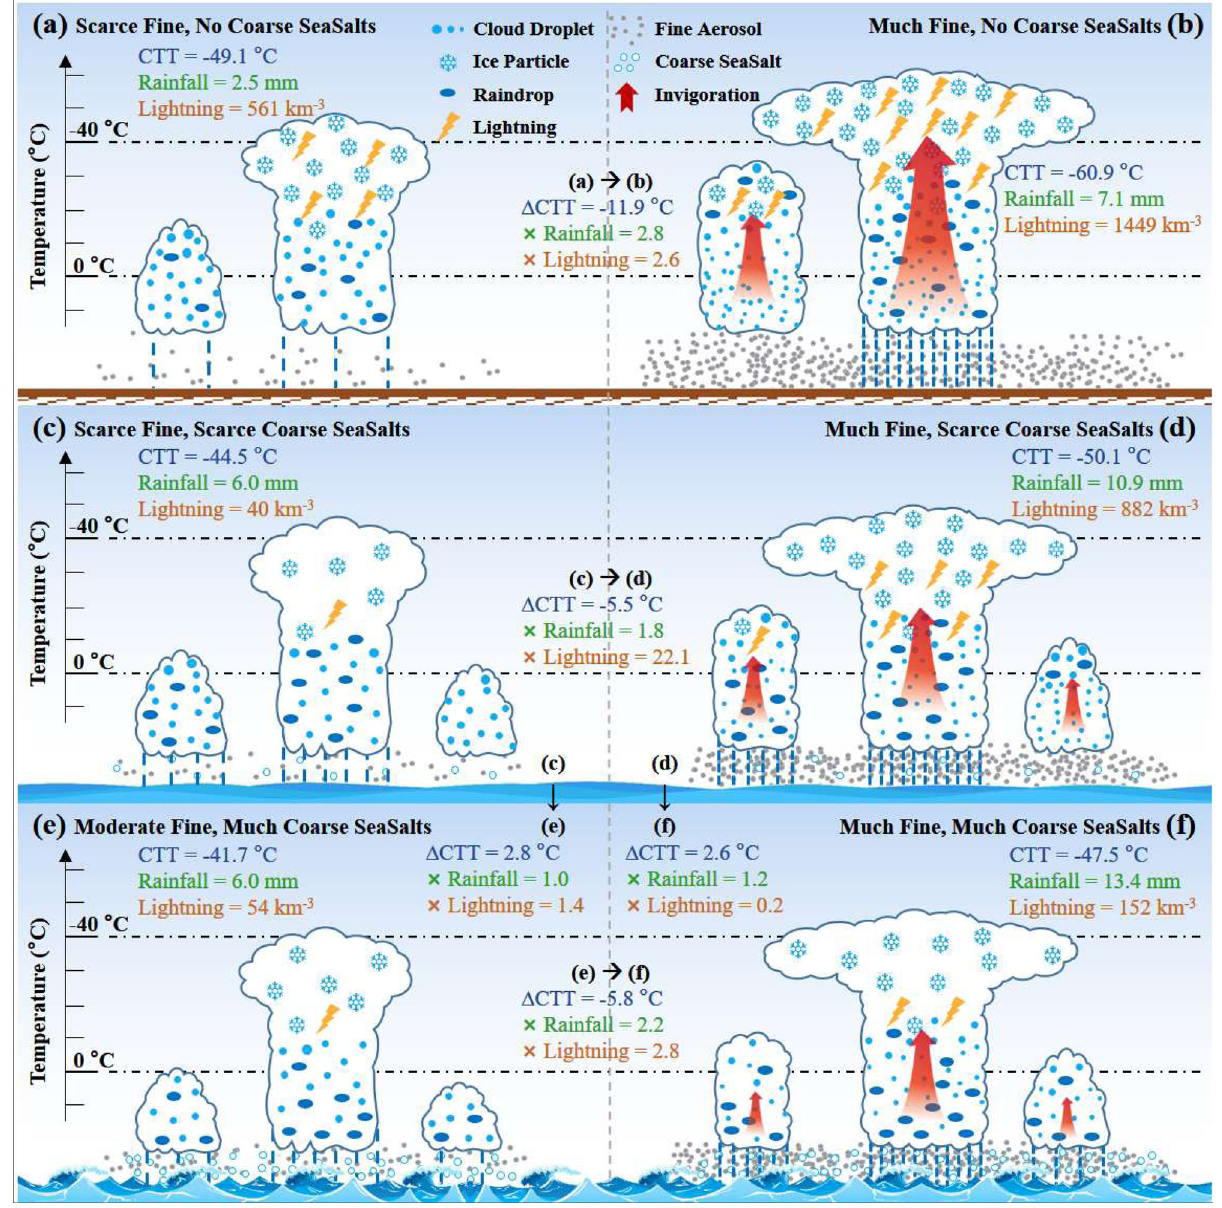
Fig. 4 Schematic illustration of the aerosol effects on DCC properties and lightning over land and ocean. The convective core cloud top temperature (CTT), domain averaged rainfall amount (i.e., rainfall depth) throughout deep concective cloud (DCC) lifetime, and lightning fl ashes per km 3 of rain volume over land ( a , b ), ocean with the lowest third (blue lines in Fig. 3) of the coarse sea salt aerosols ( c , d ) and ocean with the upper third (red lines in Fig. 3) of the coarse sea salt aerosols ( e , f ), respectively. The left column ( a , c , e ) indicates the conditions at the smallest 5% bin of fi ne aerosol mass concentrations, and the right column ( b , d , f ) indicates the conditions at the largest 5% bin. The temperature scale marks the isotherms from 0 °C to − 70 °C every 10 °C. The differences in cloud properties and lightning between panels are posted under the arrows connecting the compared panels. The Δ CTT indicates the change in CTT of the core from clean to optimal fi ne aerosol concentrations. The × rainfall indicates the respective enhancement factor of rainfall amount. The × lightning indicates the change of normalized lightning frequency from clean to maximum fi ne aerosol concentrations, as lightning keeps increasing with more fi ne aerosols beyond the optimal aerosol concentrations for rainfall amounts. The red updraft arrows symbolize the added invigoration due to adding fi ne aerosols over land ( a , b ), ocean with few ( c , d ), or with much coarse aerosols ( e , f ),